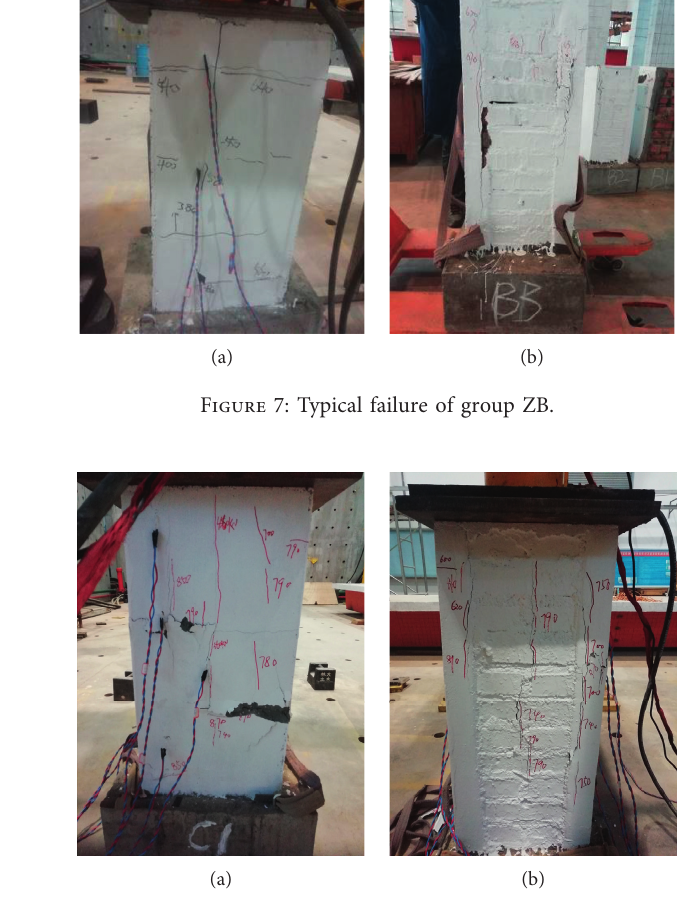
Figure 8: Typical failure of group